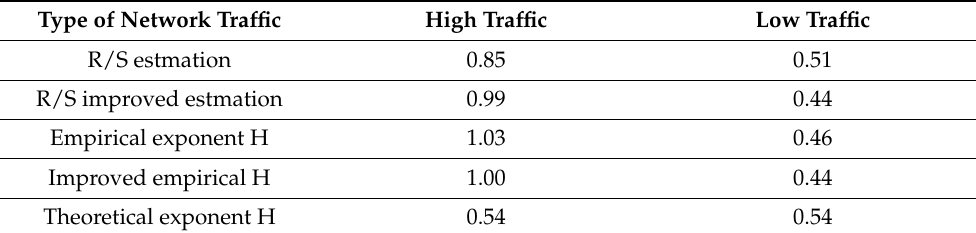
Table 6. Averaged values of Hurst exponent calculated for two types of network traffic.